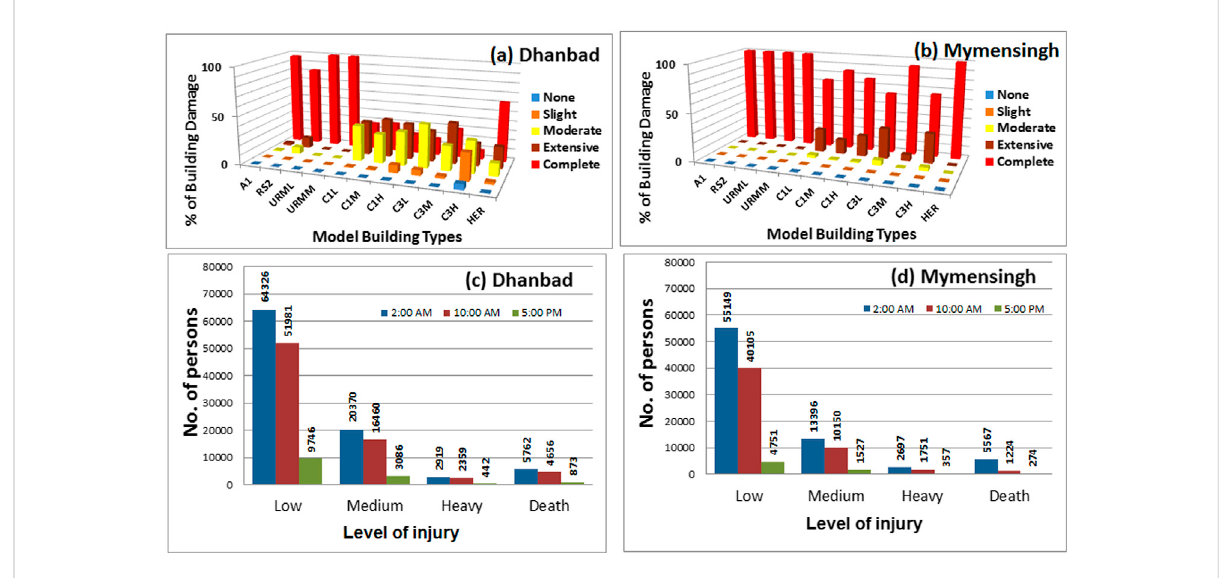
FIGURE 15 Damageprobabilitycomputedintermsof “ None, ”“ Slight, ”“ Moderate, ”“ Extensive, ” and “ Complete ” for11modelbuildingtypesinthecitiesof (A) Dhanbadand (B) Mymensinghandvariouslevelsofinjurysufferedbythehumanpopulationatthethreedistinctlydifferenttimesofthedayviz. “ night time, ” “ day time, ” and “ commuting time ” for the cities of (C) Dhanbad in Jharkhand and (D) Mymensingh in